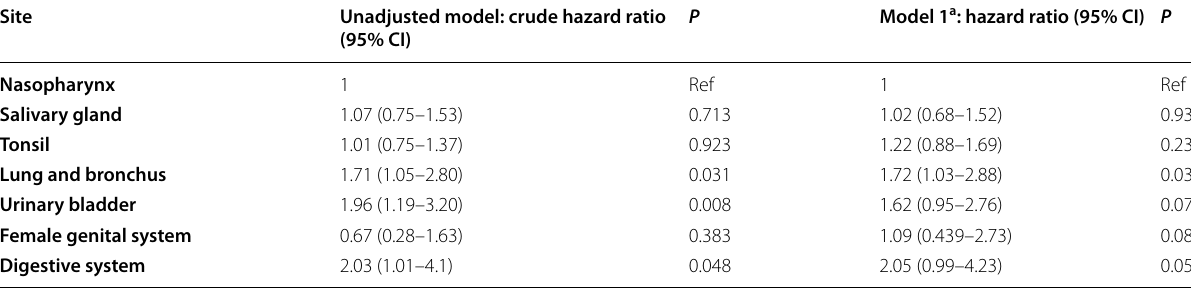
Abbreviations : CI confidence interval, Ref reference group